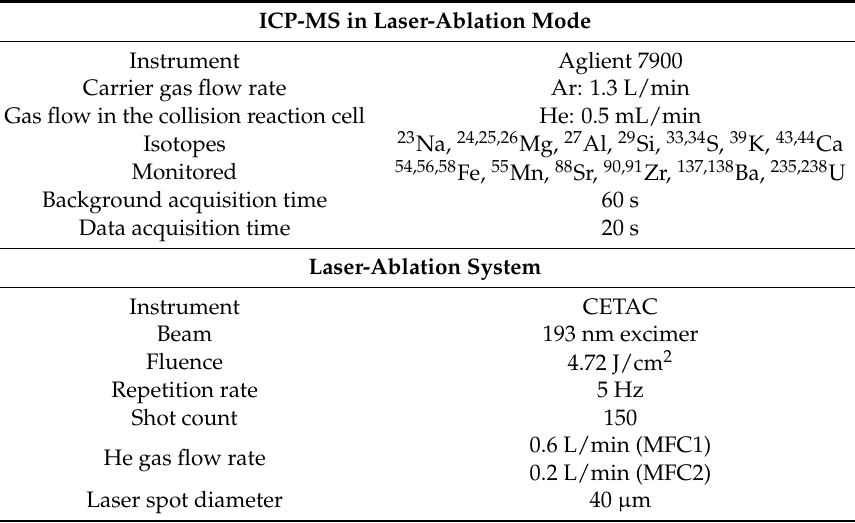
Table 1. Laser-ablation system and operation